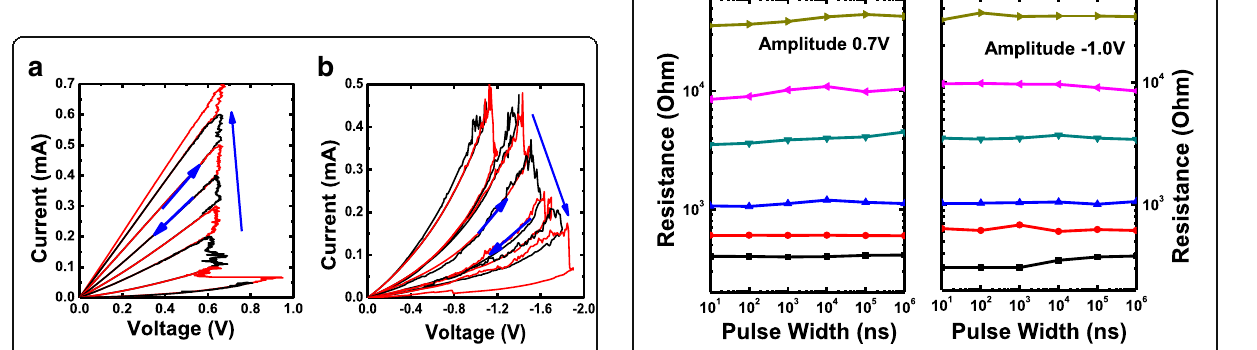
Fig. 2 Measured multilevel resistance states characteristics of the cells in the crossbar RRAM arrays. a Using current sweeping mode for SET. b Using voltage sweeping mode for RESET